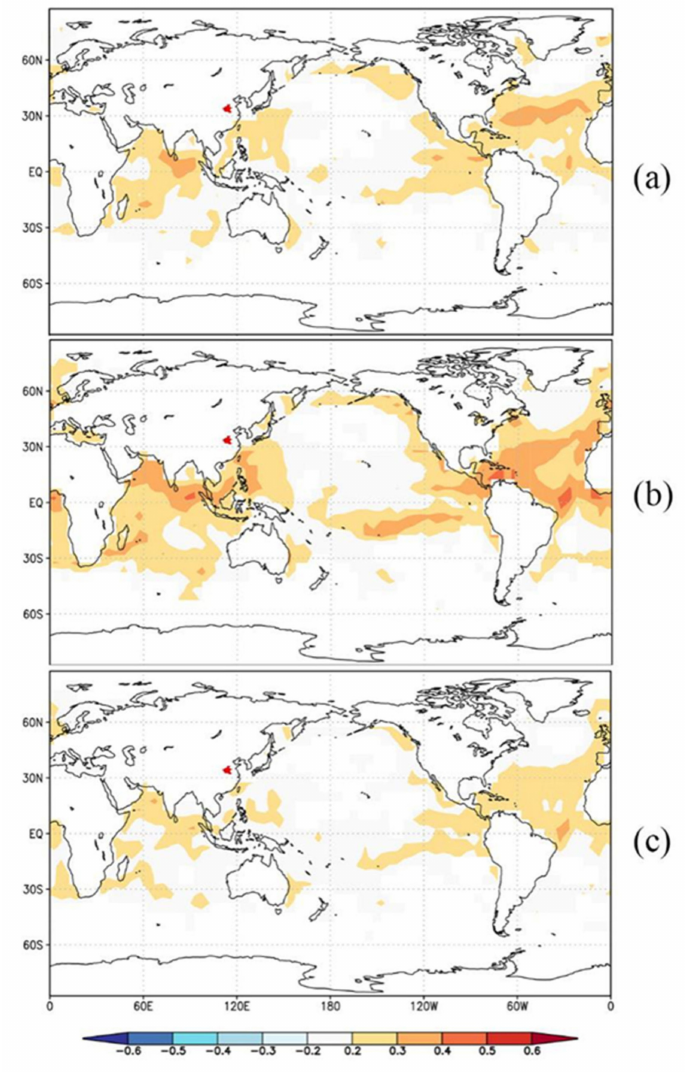
Figure 10. Spatial correlation between the TCCI ( a – c denote TCCI–high, TCCI–middle, TCCI–low, respectively) and SST. Table 4. Forecast of monthly variation of the TCCI of different grades in Henan Province in the future. High Middle